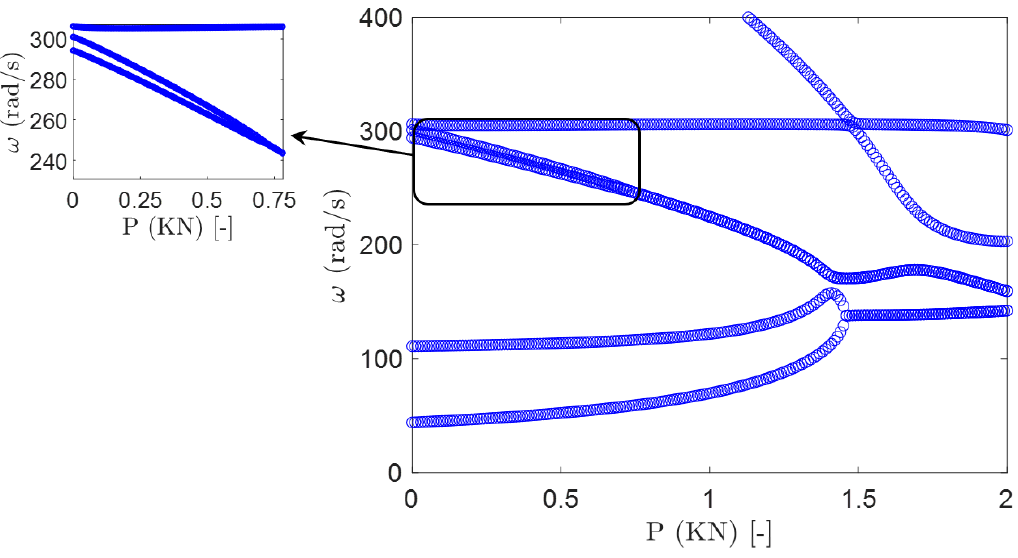
Figure 12. The e ff ect of compressive force on the rotating frequencies of the composite blade with antisymmetric layup and for θ = 30 ◦ and Ω / Ω b =